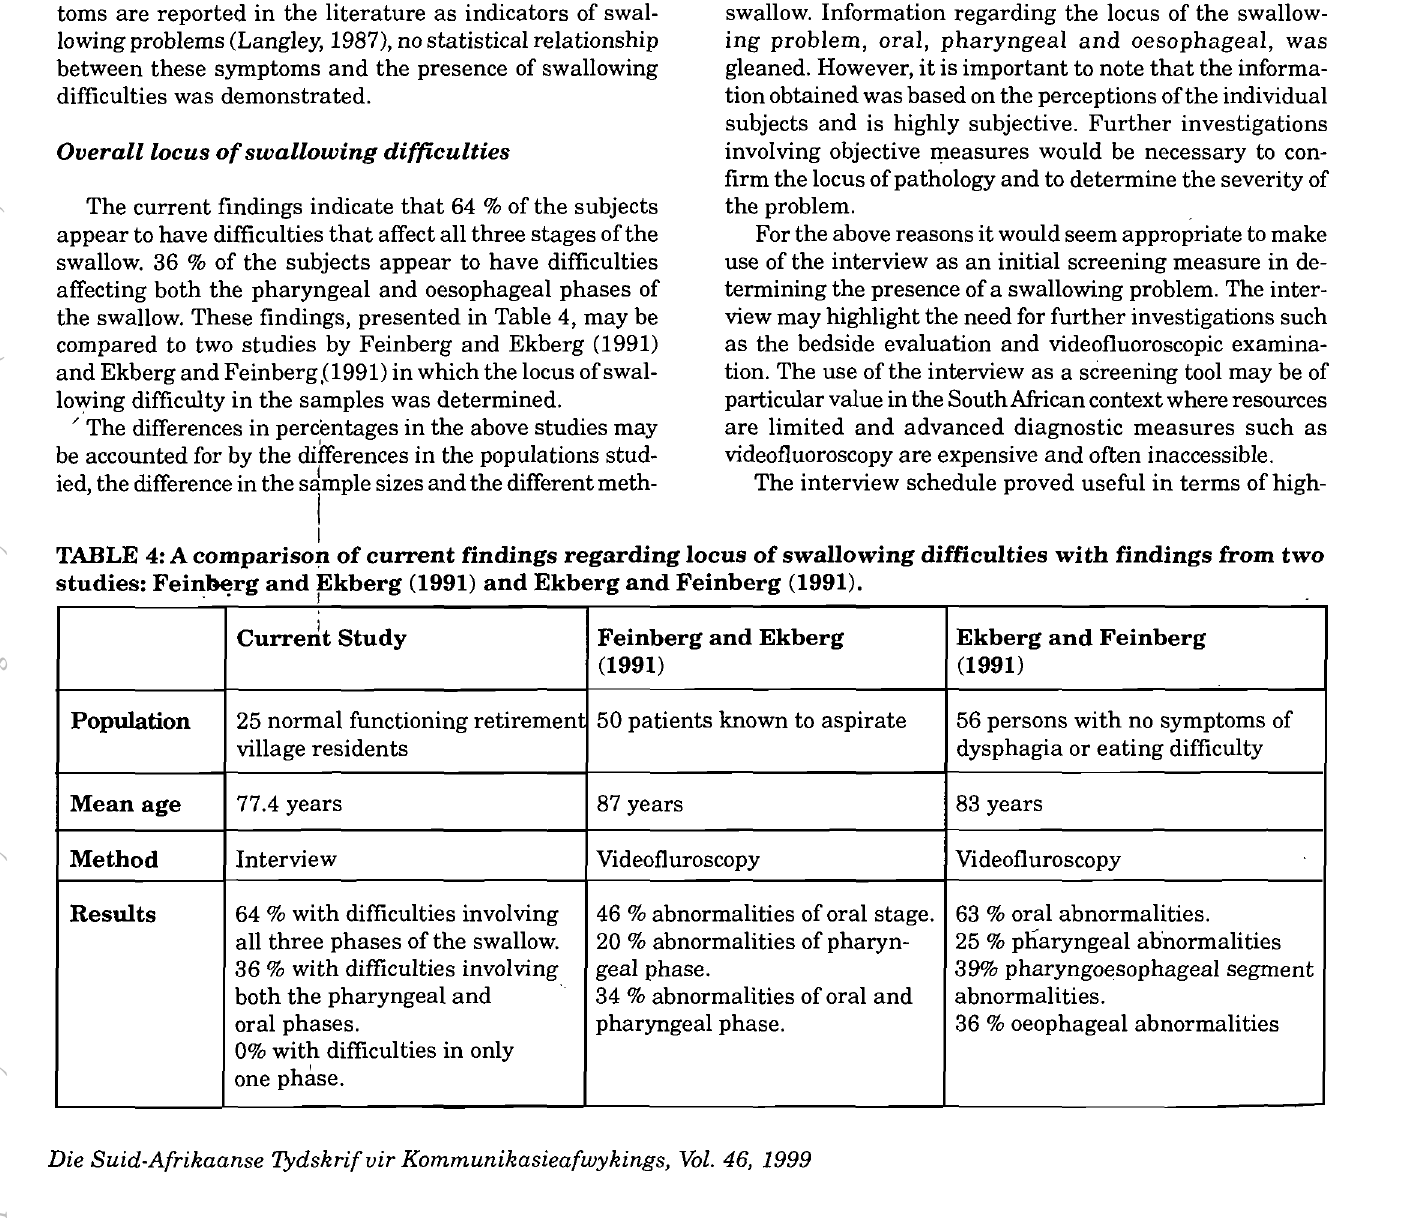
TABLE 4: A comparison of current findings regarding locus of swallowing difficulties with findings from two studies: Feinberg and Ekberg (1991) and Ekberg and Feinberg (1991). -